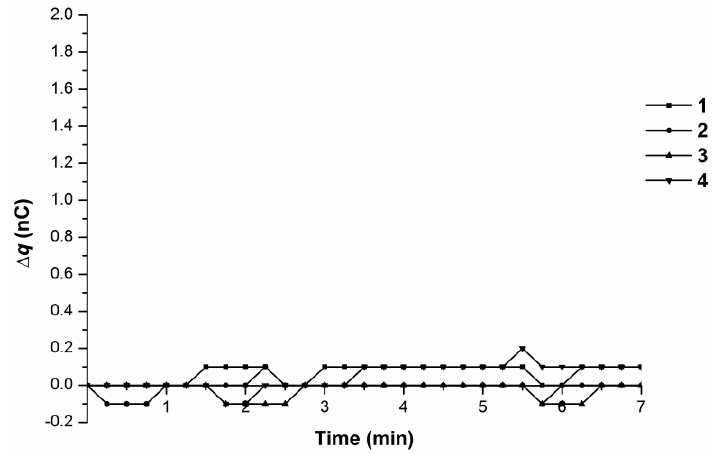
Figure 7. Time dependence curves of charge accumulation ∆q(t) upon 10 −4 M BSA solution influx from the tip in the flow-through system at 38 °C. Curves 1–4 represent parallel measurements of one and the same experimental series.